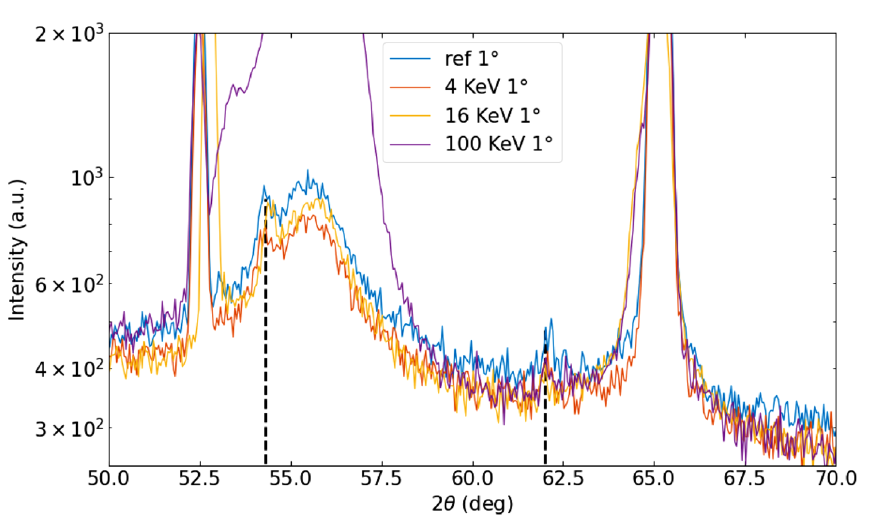
Figure 4. TiO 2 peaks